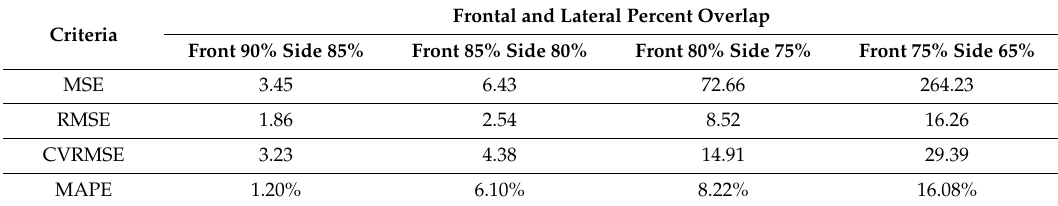
Figure 7. Error percent between manual measurements and sUAV measured segments with varying frontal and lateral overlaps. Table 7. Accuracy indicators of scenario 2.